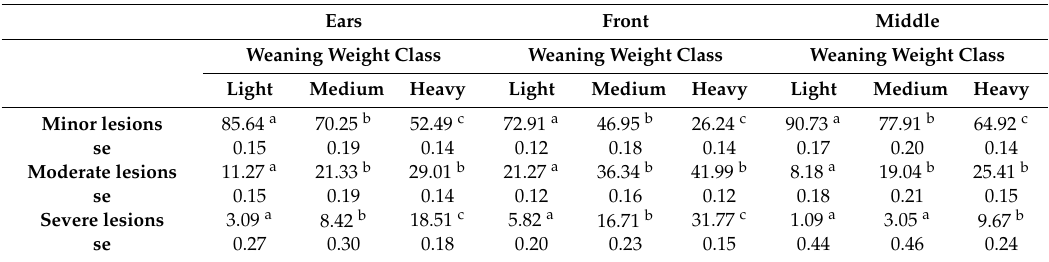
Figure 3. Estimated frequencies (%) of skin lesions per body part and rearing system on the first day after weaning (conv: conventional rearing pen; w-f: wean-to-finish rearing pen; a-b: different letters indicate significant differences within body part and score level ( p < 0.05)).